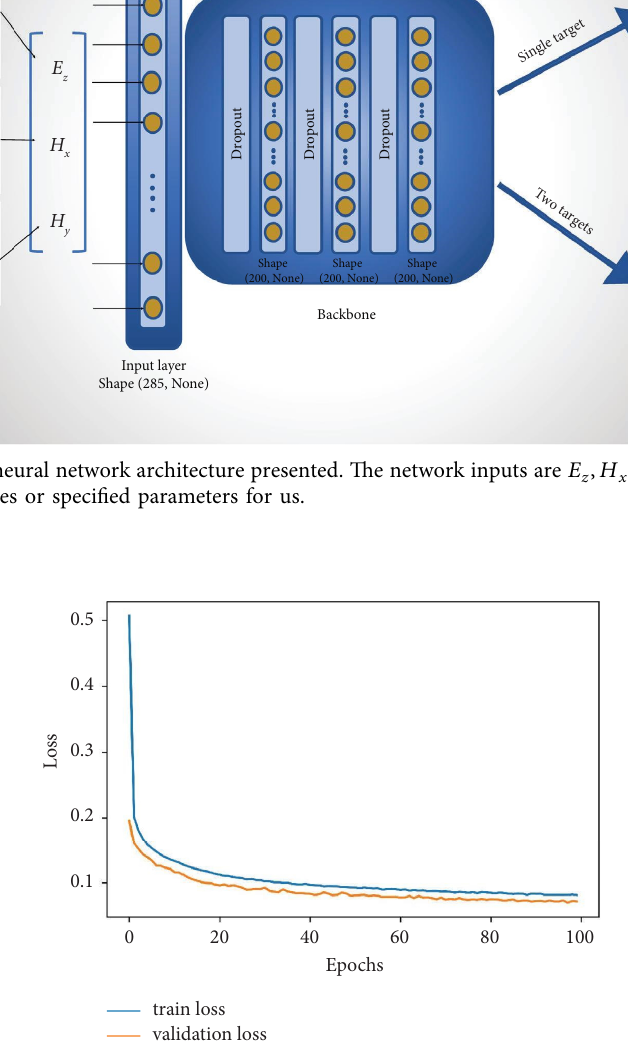
Figure 5: Training and validation loss for two-target using transfer